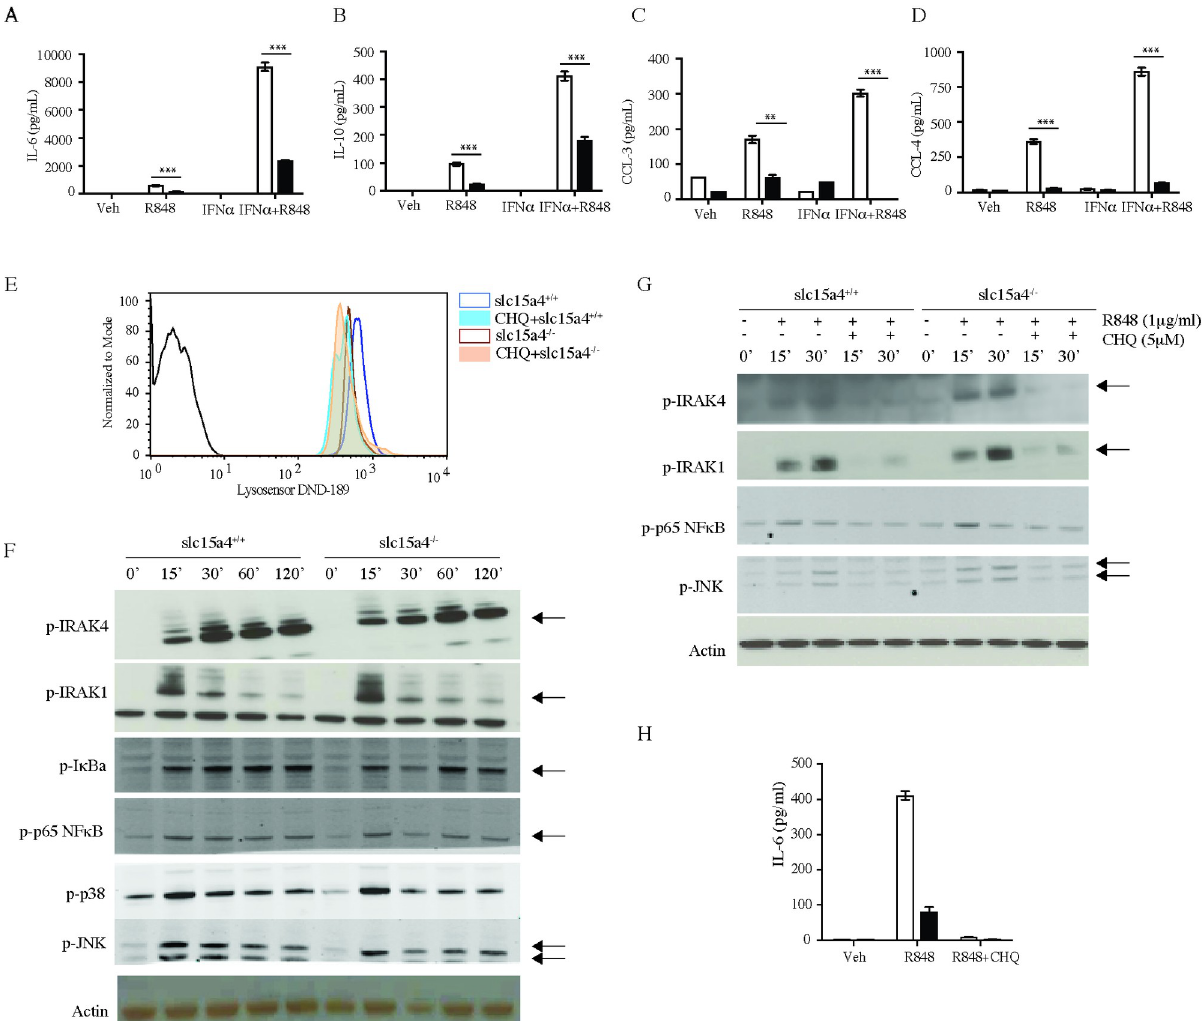
Fig 2. SLC15A4 regulates cytokine secretion but not NF κ B phosphorylation in B cells in response to TLR7 stimulation. (A-D) Cytokine and chemokine levels in the supernatants of B cells stimulated with 1 μ g/ml of R848, or 5U/ml IFN α , or both agents for 72 hours were measured by Luminex (Bio-Rad platform). (E) lysosomal pH determined by lysosensor dye and expressed as histogram overlay of wild type B cells in absence (blue) or in presence of chloroquine (filled light blue) and slc15a4 -/- B cells in absence (brown) or in presence of chloroquine (filled light orange). (F-G) Splenic B cells were stimulated with 1 μ g/ml of R848 for indicated times with or without chloroquine, and phosphorylation of signaling molecules was assessed by western blot. (H) IL-6 levels in the supernatants of B cells stimulated with 1 μ g/ml of R848 with or without chloroquine. Data is expressed as mean ± SD for triplicate samples (n = 3). White bars, wild-type mice (C57BL/6); black bars, slc15a4 -/- mice (on C57BL/6 background). � p < 0.05, �� p < 0.005, ��� p < 0.0005.